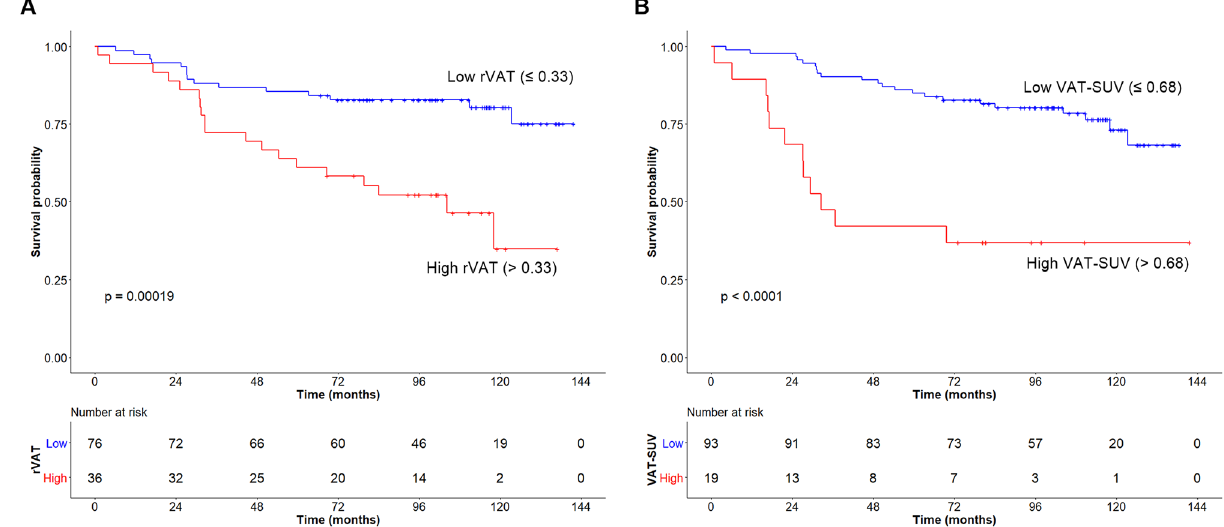
Figure 3. Kaplan–Meier curves of overall survival stratified according to rVAT ( A ) and VAT-SUV ( B ) in females (n =